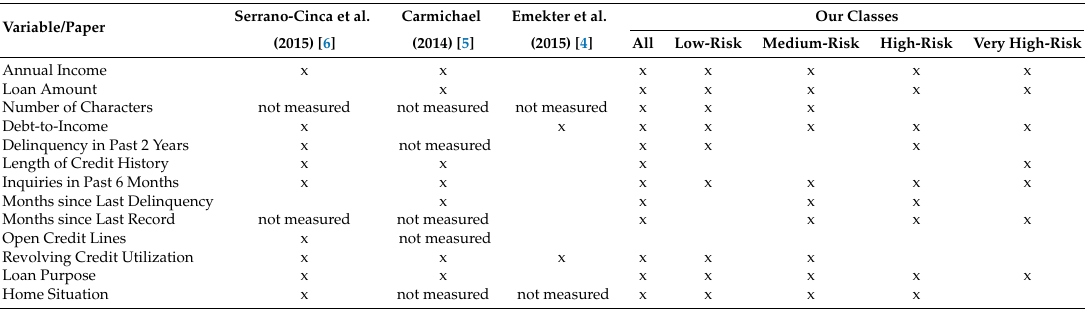
Table 5. Comparison of